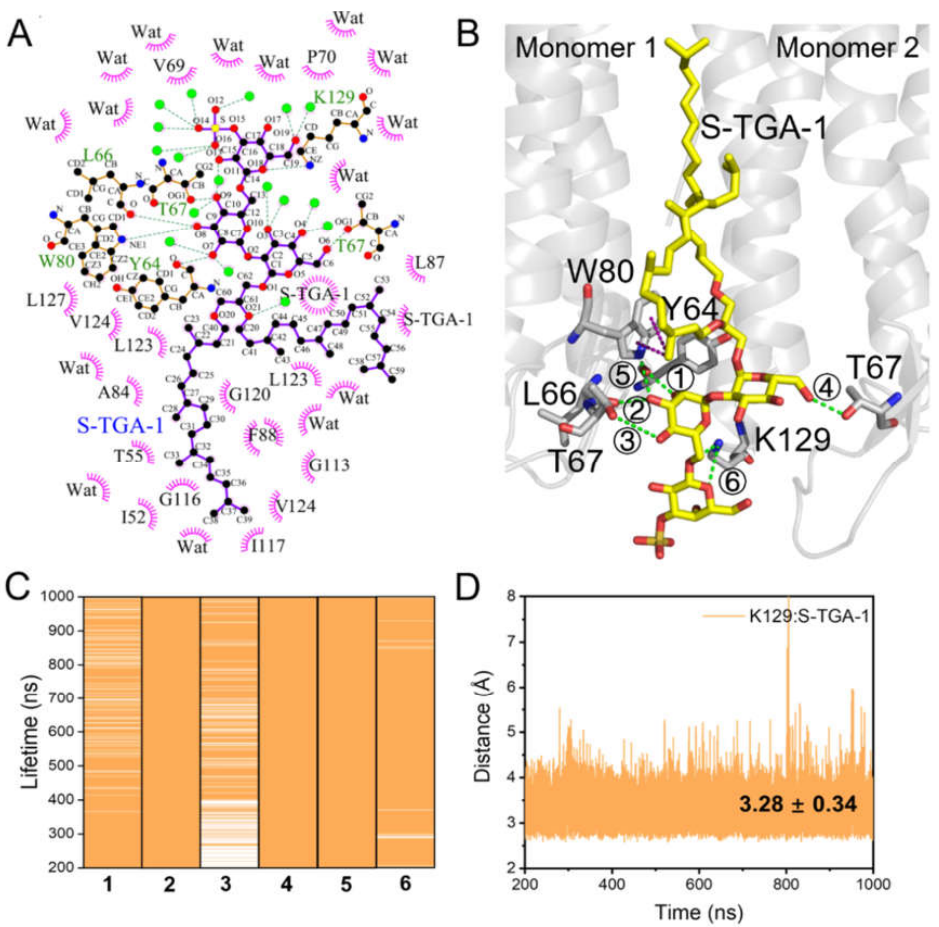
Figure 3. Schematic representation of S-TGA-1 binding to the bR trimer. ( A ) The LigPlot+ diagrams of the S-TGA-1 binding sites from the last snapshot of M1; the green dotted lines and the pink spoked arcs represent hydrogen bond (H-bond) and hydrophobic interactions, respectively; ( B ) the possible H-bond (green dotted line) and Pi–alkyl hydrophobic interactions (purple dotted line) be- tween S-TGA-1 with bR. Monomer1 and Monomer2 represent the two adjacent monomers in the bR trimer. The grey sticks represent the interacting residues, and the yellow sticks represent S-TGA-1; ( C ) evaluation of the lifetimes of the H-bond interactions for S-TGA-1; see ( B ) for the description of the numbers: (1) Y64∙∙∙2-hydroxyl of mannose; (2) L66∙∙∙2-hydroxyl of mannose; (3) T67∙∙∙3-hydroxyl of mannose; (4) T67∙∙∙6-hydroxyl of glucose; (5) W80∙∙∙2-hydroxyl of mannose; (6) K129∙∙∙ether group of galactosyl-3-sulfate; ( D ) time evolution of the distance between K129 and the galactosyl-3-sulfate of S-TGA-1. These interaction modes were reproducible in the second time-repeating simulation, as shown in Figures S3 and S4.